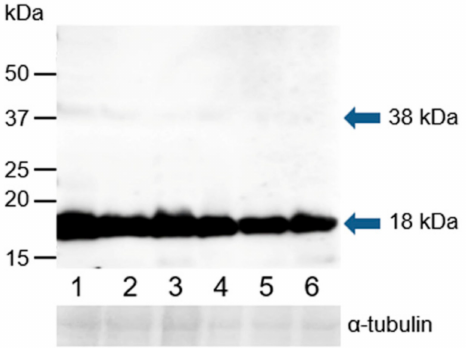
Figure 11. Reaction of anti-GPER1 (K-19) with proteins extracted from bull spermatozoa. Western blotting with antibody K-19 was performed to analyze bull spermatozoa proteins after their separation by SDS-PAGE (12% gel) under reducing conditions; 1, spermatozoa from the caput epididymis; 2, spermatozoa from the corpus epididymis; 3, spermatozoa from the cauda epididymis; 4, freshly ejaculated spermatozoa; 5, spermatozoa after in vitro capacitation; 6, spermatozoa after the acrosome reaction. The arrows indicate di ff erent protein isoforms of GPER1. The protein concentration in sperm samples was checked by α -tubulin